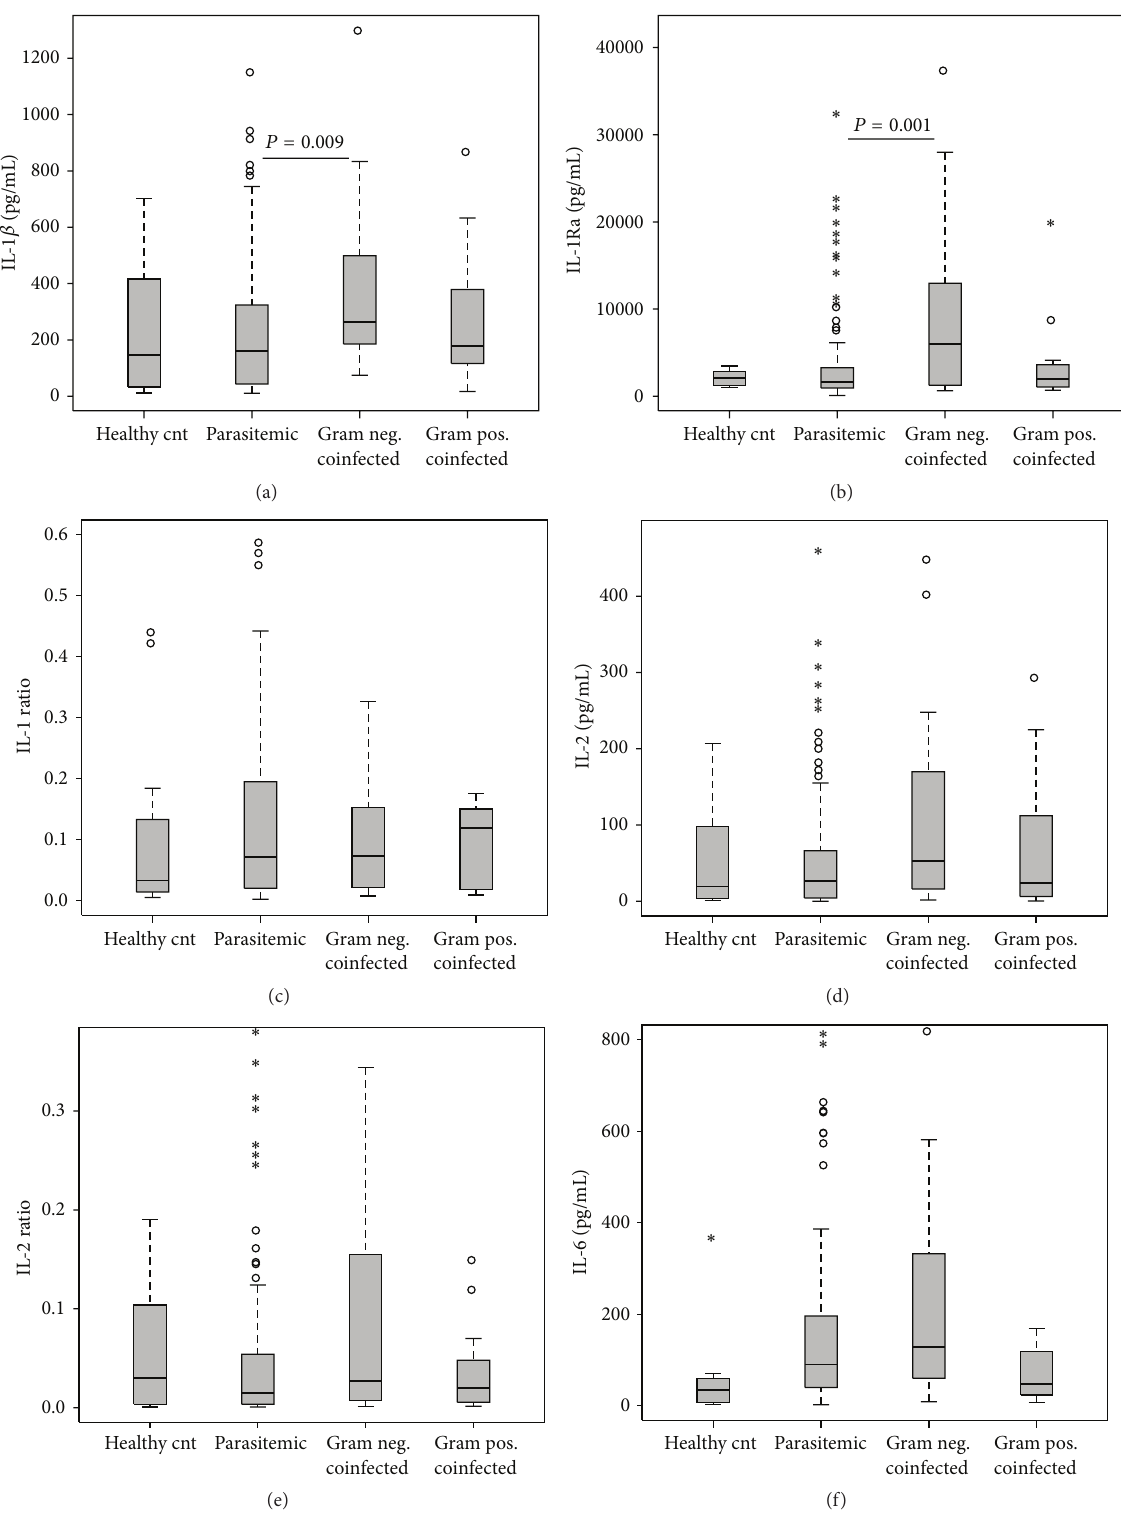
Figure 2: Proinflammatory mediator profiles. Data are presented as box plots with whiskers and outliers. The box represents the interquartile range, while the whiskers represent the 10th and 90th percentiles. The line across the box indicates the median value, open circles ( ∘ ) represent extremes, and asterisks ( ∗ ) depict outliers. Pair-wise comparisons between groups were conducted with Mann-Whitney 𝑈 test. All units are in pg/mL. (a) IL-1 𝛽 (Kruskal-Wallis [K-W], test 𝑃 = 0.027 ). (b) IL-1Ra (K-W test, 𝑃 = 0.005 ). (c) IL-1 Ratio (K-W, test 𝑃 = 0.854 ). (d) IL-2 (K-W test, 𝑃 = 0.068 ). (e) IL-2 Ratio (K-W test, 𝑃 = 0.575 ). (f) IL-6 (K-W test, 𝑃 = 0.115